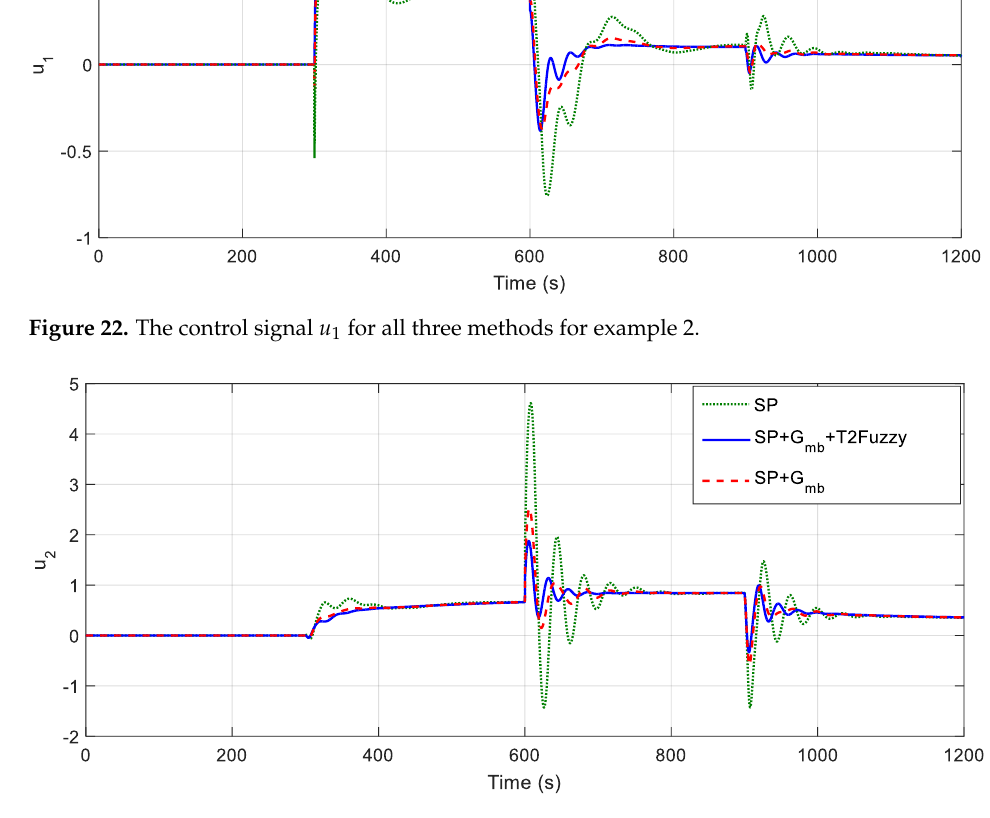
Figure 23. The control signal 𝑢 2 for all three methods for example 2.